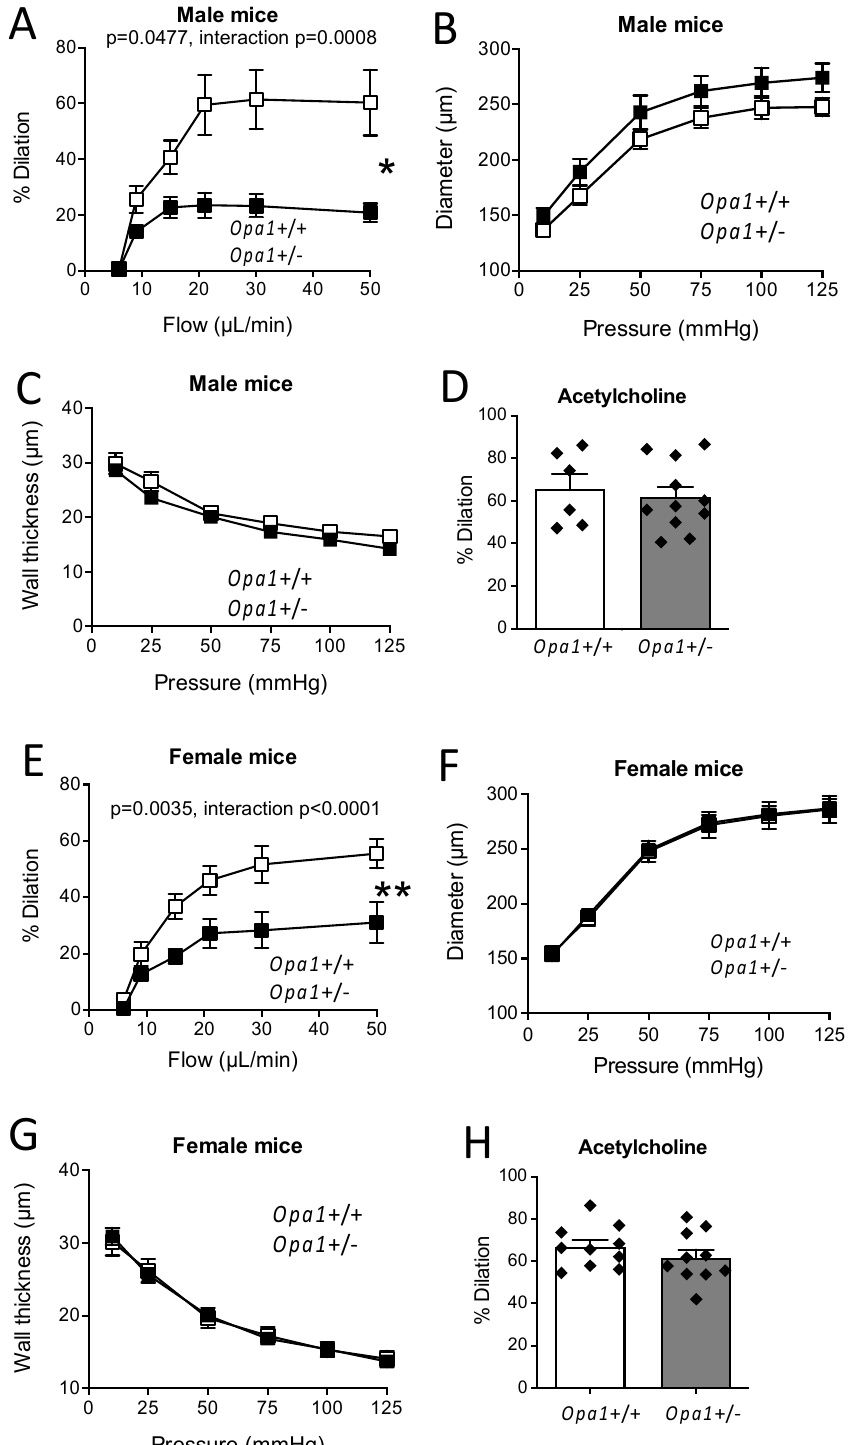
Figure 3. Effect of Opa1 haploinsufficiency on flow-mediated dilation. Flow-mediated dilation was measured in mesenteric resistance arteries isolated from Opa1 +/− and Opa1 +/+ male ( A ) and female ( E ) mice. In the same arteries, arterial inner diameter ( B , F ) and wall thickness ( C , G ) were measured in response to stepwise increases in pressure. D , H : Acetylcholine (1 µM)-mediated dilation. Means ± SEM are shown (n = 6 male EC-WT, 11 male EC-Opa1, 10 female EC-WT and 10 EC-Opa1 mice). Two-way ANOVA for repeated measurements ( A – C and E – G ). NS, two-tailed Mann–Whitney test, D and H .